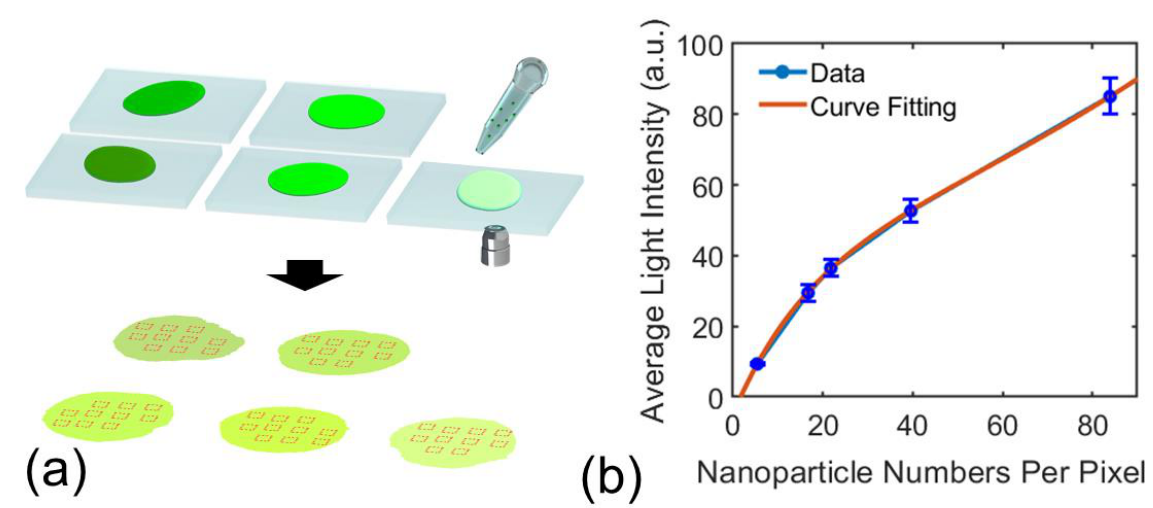
Figure 2. ( a ) Illustration of calibrating the relation between the nanoparticles’ fluorescence intensity and nanoparticle numbers. ( b ) The relation between the measured average fluorescent light intensity of nanoparticles and the number of nanoparticles per unit area (1 µm × 1 µm).